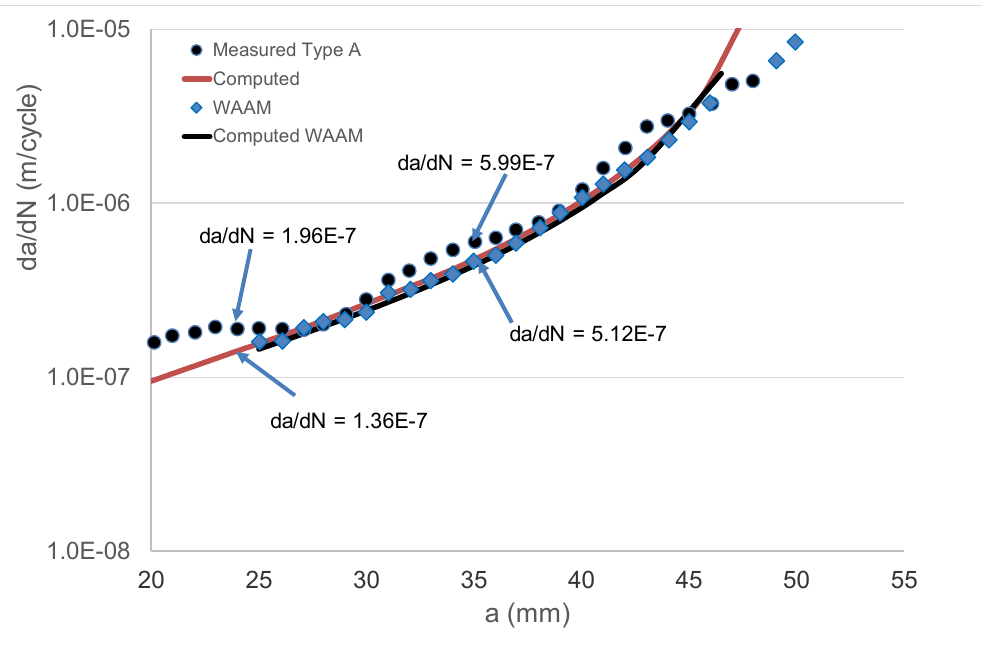
Figure 13. Comparison between the measured and computed growth rate (da/dN) versus crack length ( a ) curves for the Type A specimens.